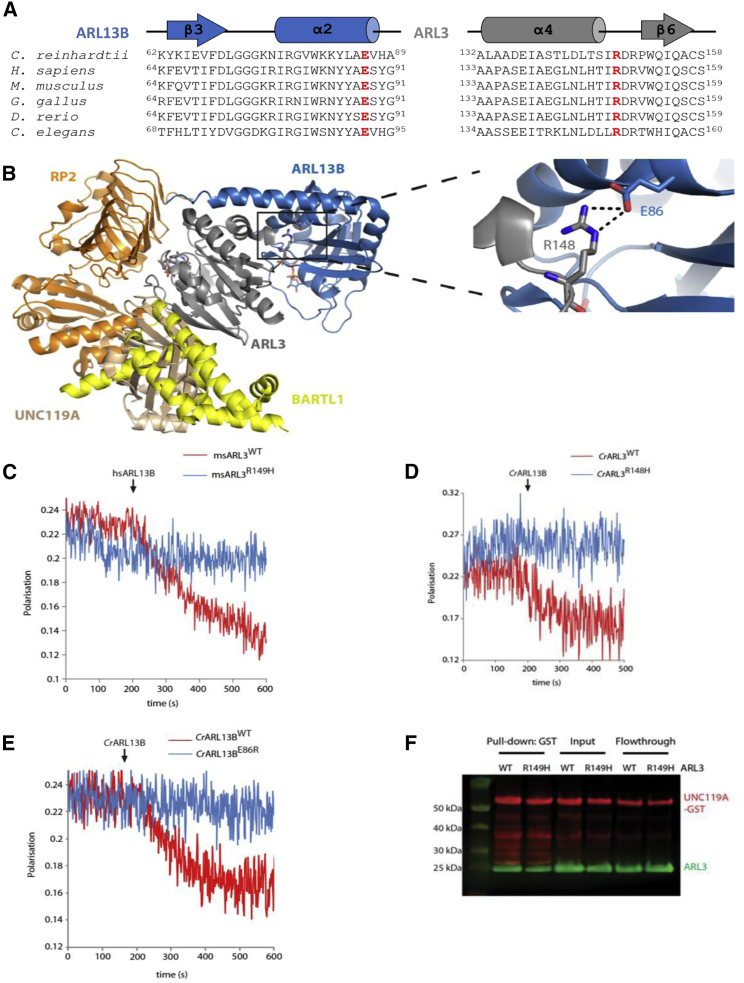
The Human ARL13B-ARL3 Complex Is Predicted to Involve an Interaction between Evolutionarily Conserved Glutamate and Arginine Residues(A) Partial amino acid sequence alignments of the ciliary GEF, ARL13B, and ARL3. Highlighted in red are the evolutionarily conserved glutamate residue located in the switch II domain of ARL13B (E86 [Glu86] in C. reinhardtii ARL13B [CrARL13B]) and the arginine residue in the loop region between the α4 and β6 domains of ARL3 (R148 [Arg148] in CrARL3).(B) Superimposition of the crystal structures of ARL3 (gray) in complex with its known interactors: the effectors UNC119A (salmon; PDB: 4GOJ15) and BARTL1 (yellow; PDB: 4ZI221), the GAP RP2 (orange; PDB: 3BH617), and GEF ARL13B (blue; PDB: 5DI319). On the right side is a zoomed-in view of the salt bridge between Glu86 and Arg148 at the CrARL13B-CrARL3 complex interface.(C) Assay of GEF activity for murine WT ARL3 (ARL3WT) and p.Arg149His ARL3 (ARL3R149H). Fluorescence polarization was measured for 1 μM mantGDP-loaded ARL3, to which 400 μM GppNHp and 5 μM H. sapiens ARL13B (HsARL13B) were added. Nucleotide exchange was shown by only ARL3WT.(D) Assay of GEF activity with fluorescence polarization measurements of 0.5 μM mantGDP-loaded CrARL3WT and CrARL3R148H, to which 10 μM GppNHp (GTP analog) and 5 μM CrARL13B⋅GppNHp were added at the indicated time points. Only CrARL3WT showed nucleotide exchange, as indicated by the drop in fluorescence polarization.(E) Assay of GEF activity with fluorescence polarization measurements of 0.5 μM mantGDP-loaded CrARL3WT and 5 μM CrARL13B⋅GppNHpWT or CrArl13bE86R, to which 10 μM GppNHp (GTP analog) was added at the indicated time points. Only CrArl13bWT showed nucleotide exchange, as indicated by the drop in fluorescence polarization.(F) 30 μg of full-length UNC119A-GST was used to pull down 60 μg of murine ARL3WT and ARL3R149H that were loaded with the GTP analog GppNHp. Proteins were detected on immunoblots with anti-GST (red) and anti-His (green) antibodies.